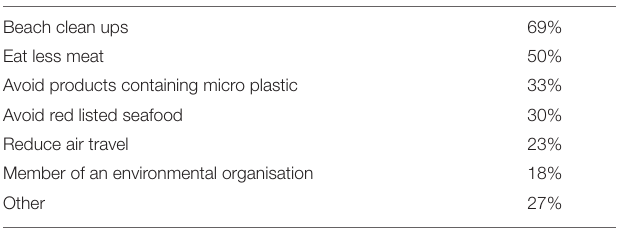
TABLE 1 | Frequency of respondents participating in specific environmentally responsible activities ( n = 218). Beach clean